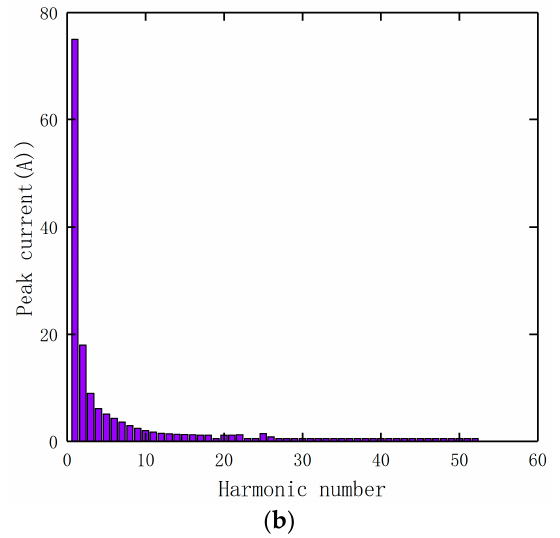
Machines 2022 , 10 , x FOR PEER REVIEW Figure 5. The harmonic decomposition waveform of the PWM current and its harmonic analysis: ( a ) the harmonic decomposition of PWM current; ( b ) the current harmonic.